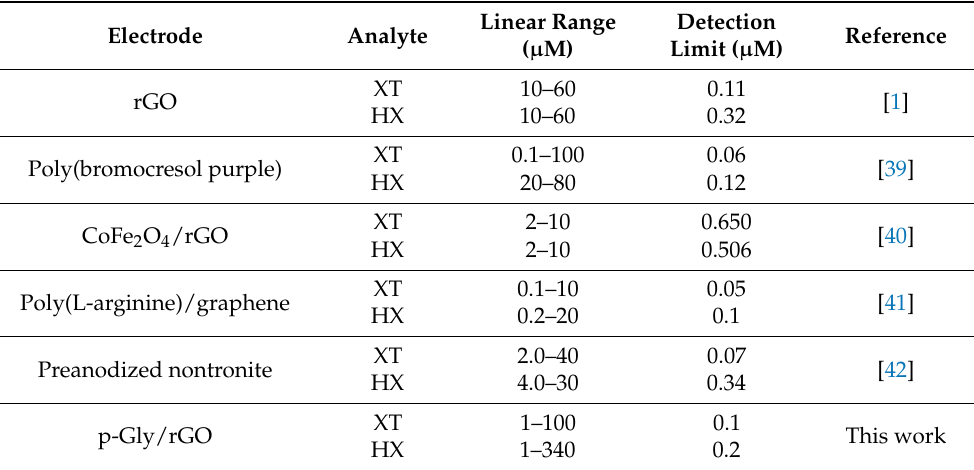
Table 1. Comparison of determination performance of XT and HX of p-Gly/rGO/GCE with the recently published